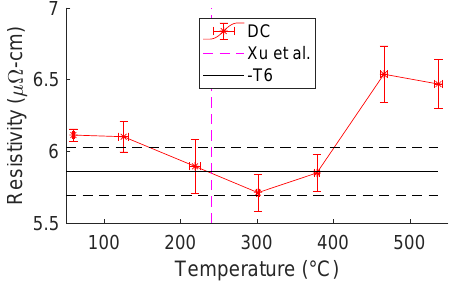
Figure 25. Direct comparison of testing described in Xu et al. [3] and DC pulse testing; Test length: 220